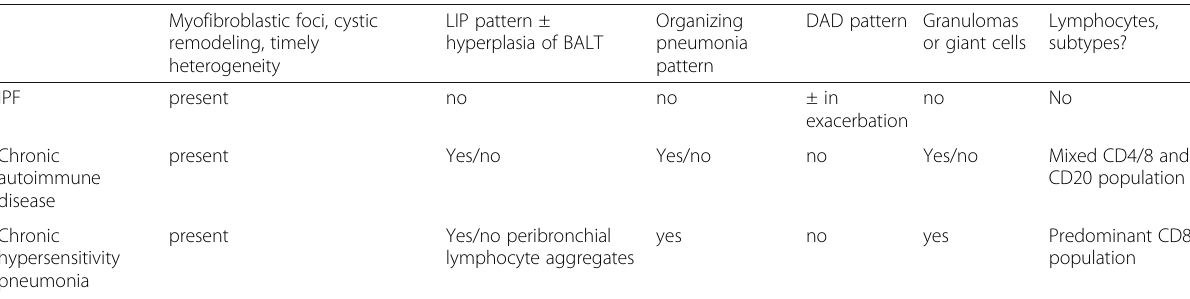
LIP pattern ± hyperplasia of BALT